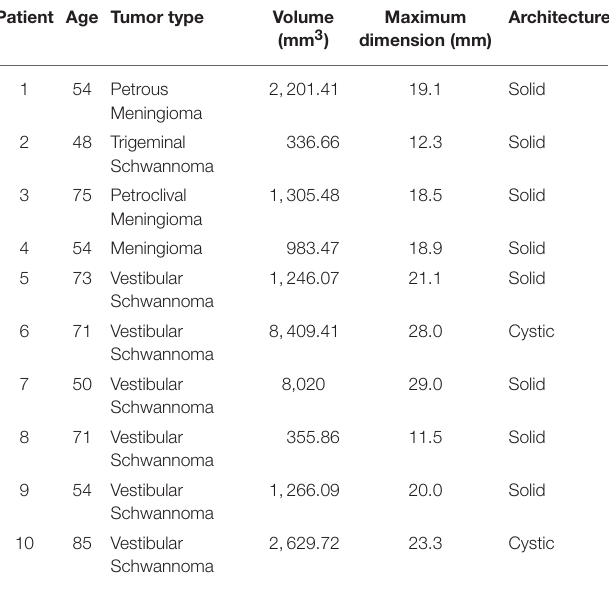
TABLE 1 | Patient details with type of posterior cranial fossa tumor and